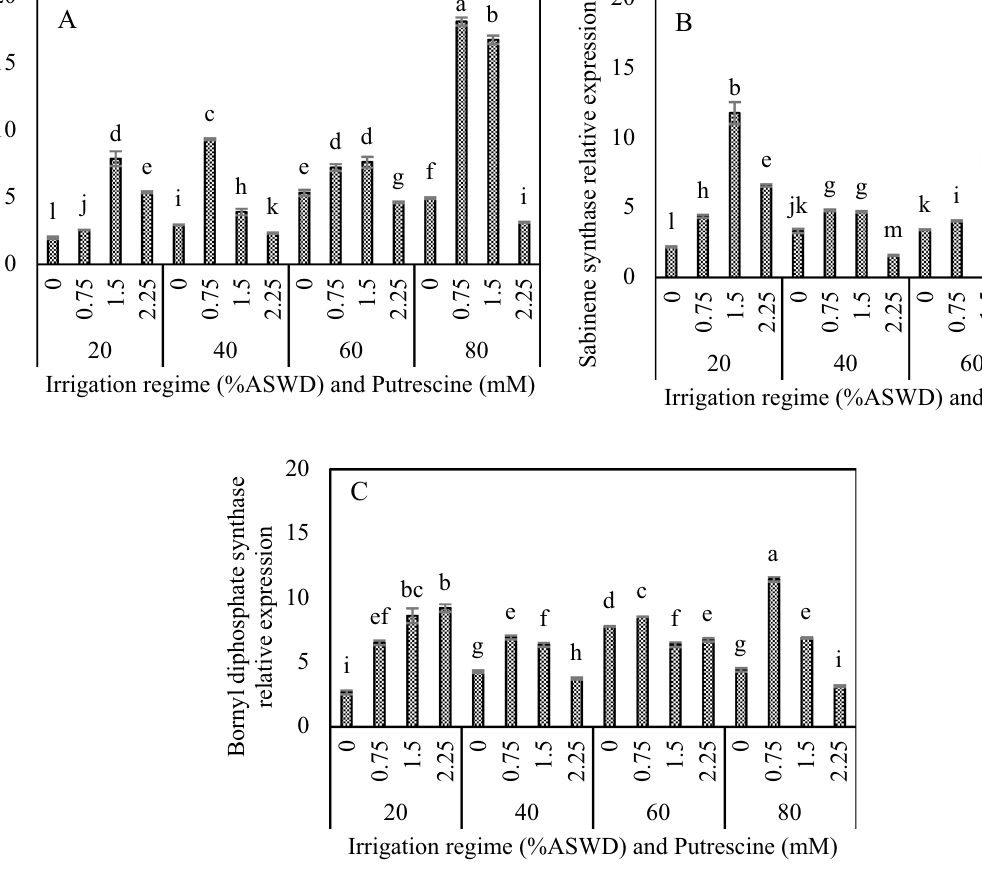
Figure 2. Interaction between irrigation regime and putrescine on cineole synthase ( A ), sabinene synthase ( B ) and bornyl diphosphate synthase ( C ) relative expression. The different letters show significantly different at the level of 0.01. The error bars represent standard